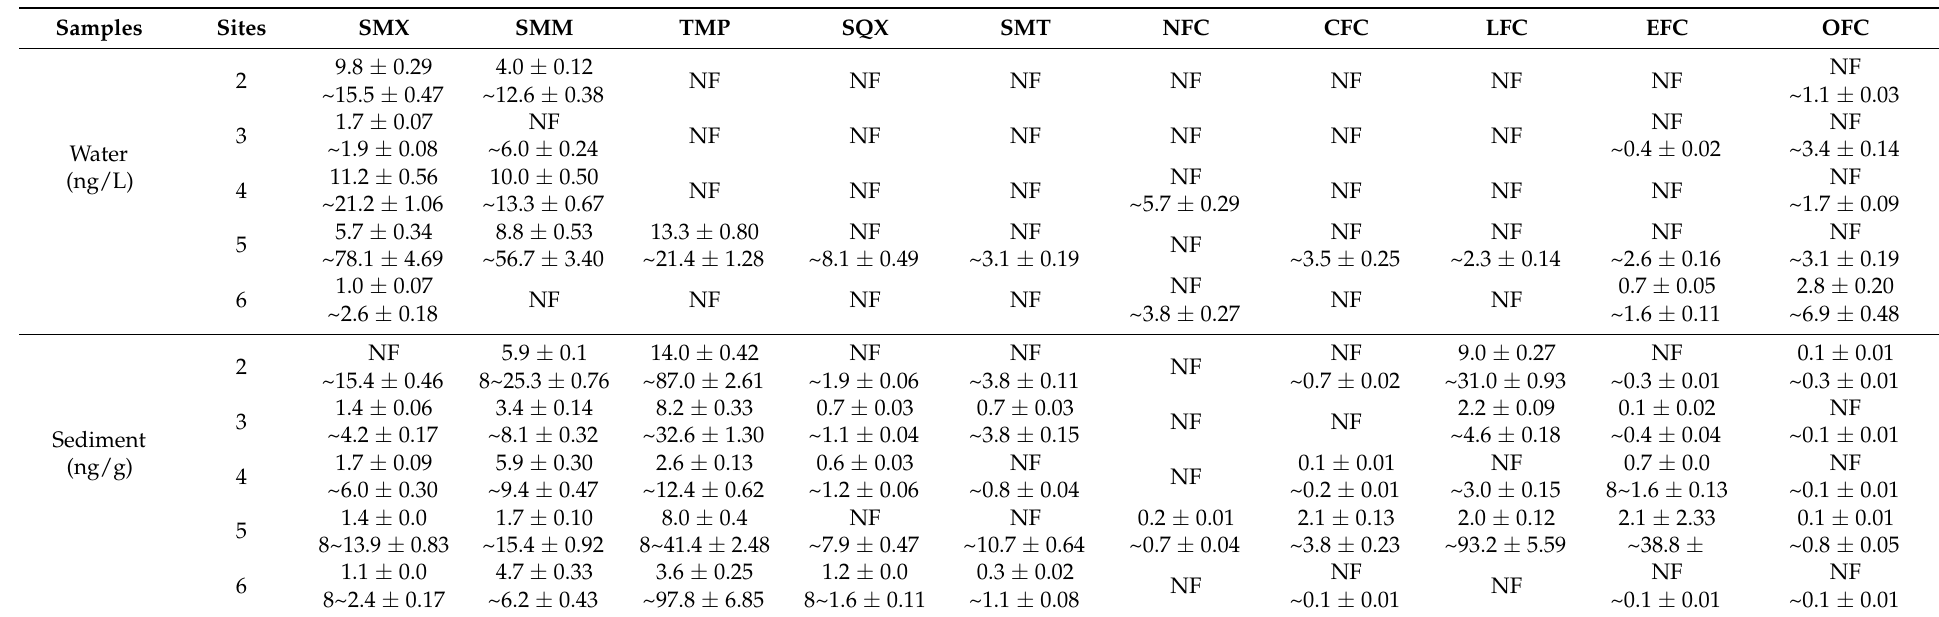
Table 3. Concentrations of antibiotics at the water intakes of representative water